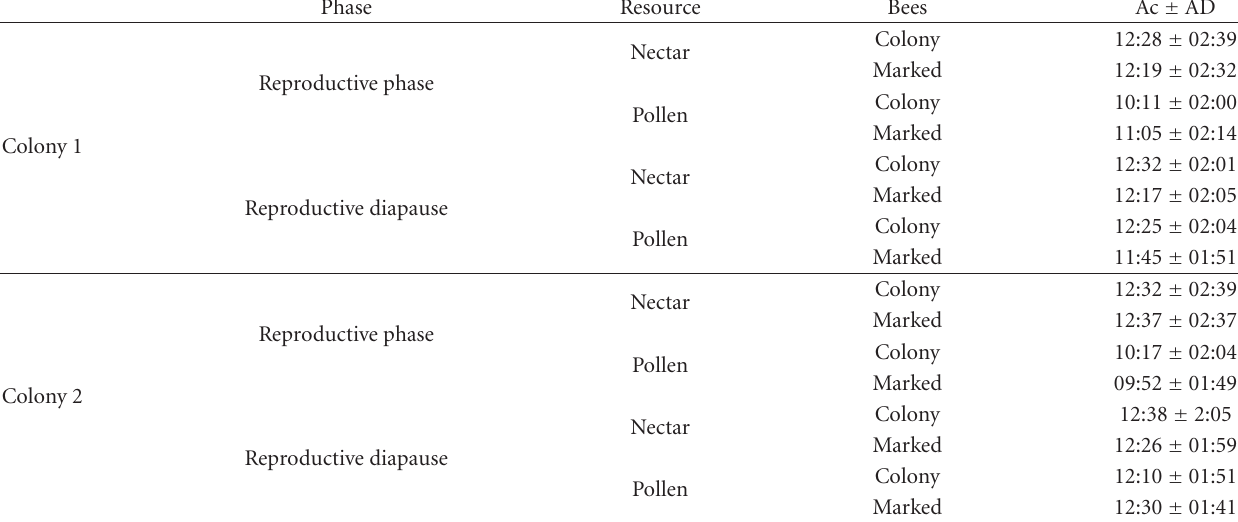
Table 5: Acrophases (Ac) and angular deviations (AD) of the total number of bees collecting nectar and pollen, and of the marked bees of colonies 1 and 2 of Plebeia remota , in the reproductive phase and diapause.